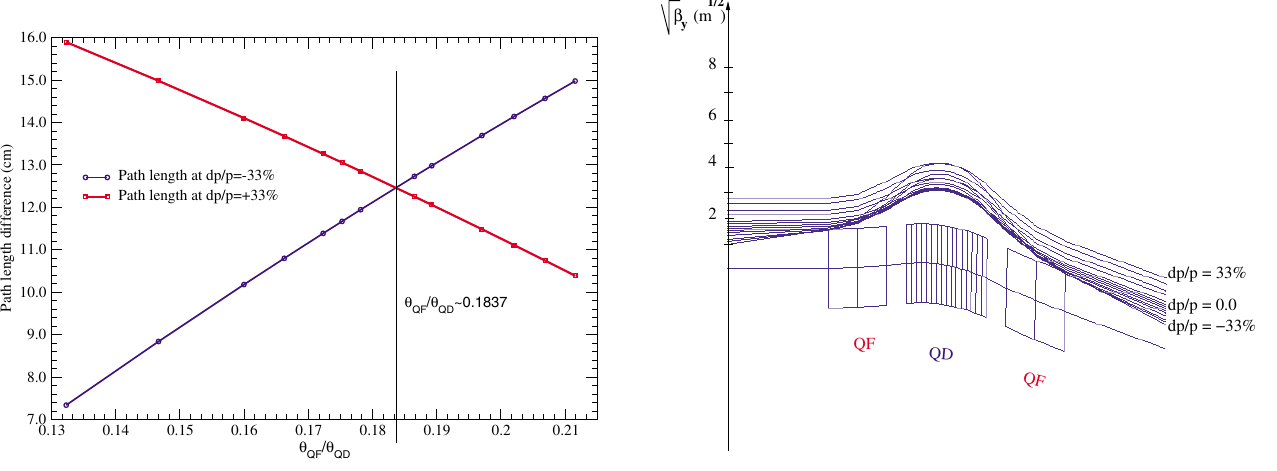
FIG. 16. (Color) Dependence on momentum of (cid:2)(cid:2)(cid:2)(cid:2)(cid:2)(cid:2) (cid:5) lated by the PTC